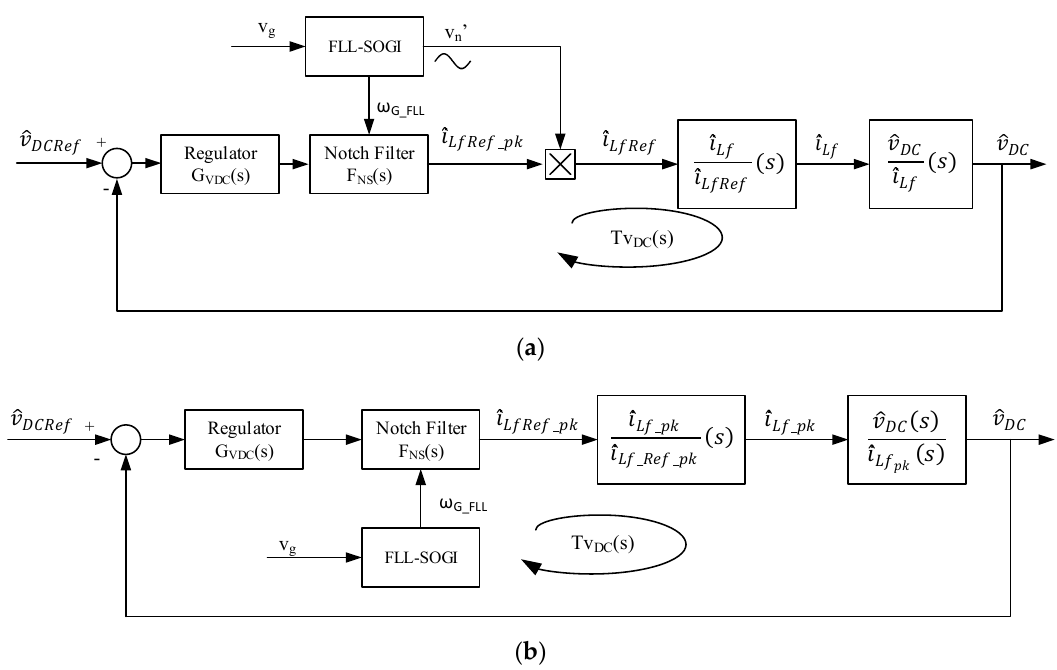
Figure 3. Control loop of the DC-link voltage (V DC ) with second order generalized integrator (SOGI) notch filter: ( a ) detailed model, ( b ) equivalent model.